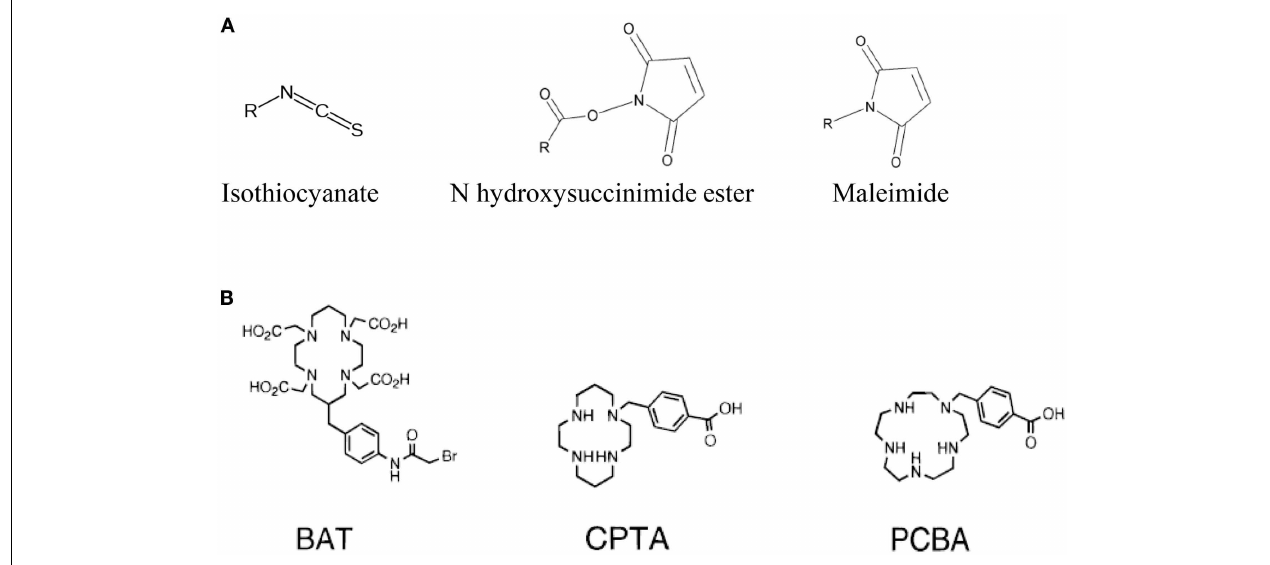
FIGURE 2 | Main functional groups used to covalently link the peptide moiety (A) and examples of BFCs (B) . BAT is a derivative ofTETA; CPTA is a derivative of cyclam, and PCBA is a derivative of cyclen (see Table 1 ). BAT is